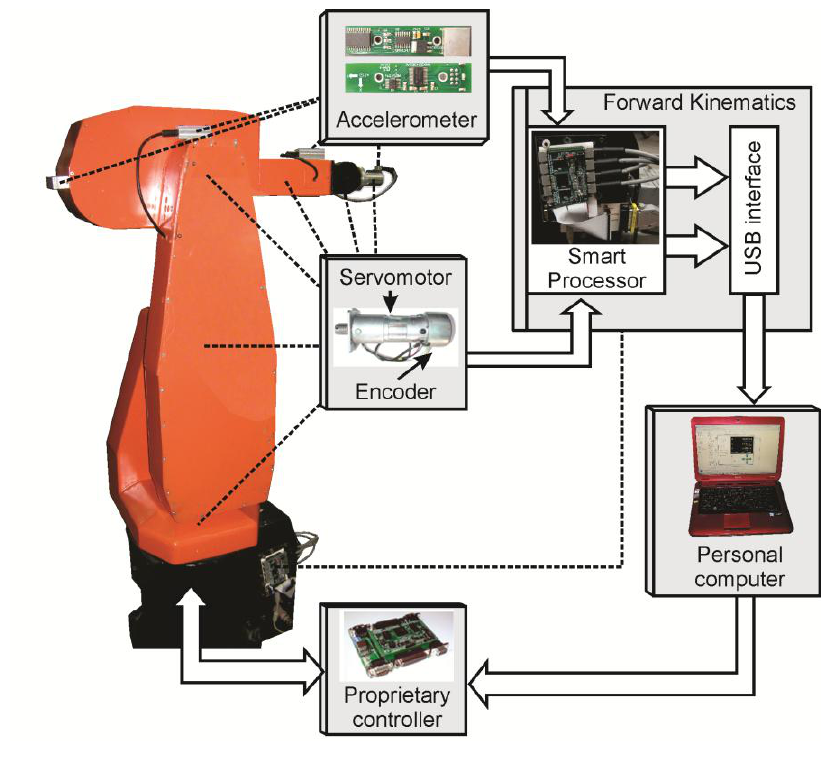
Figure 7. Experimental setup.